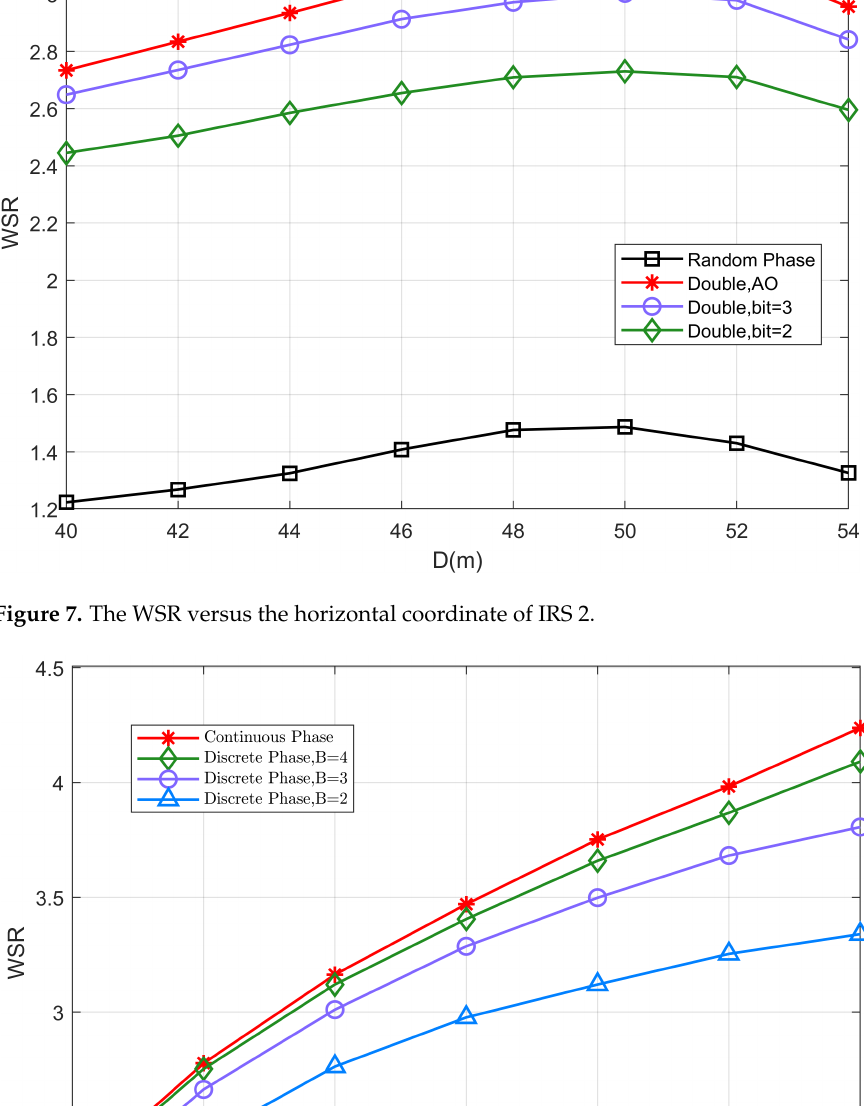
Figure 6. The WSR versus the total number of the reflection elements N.